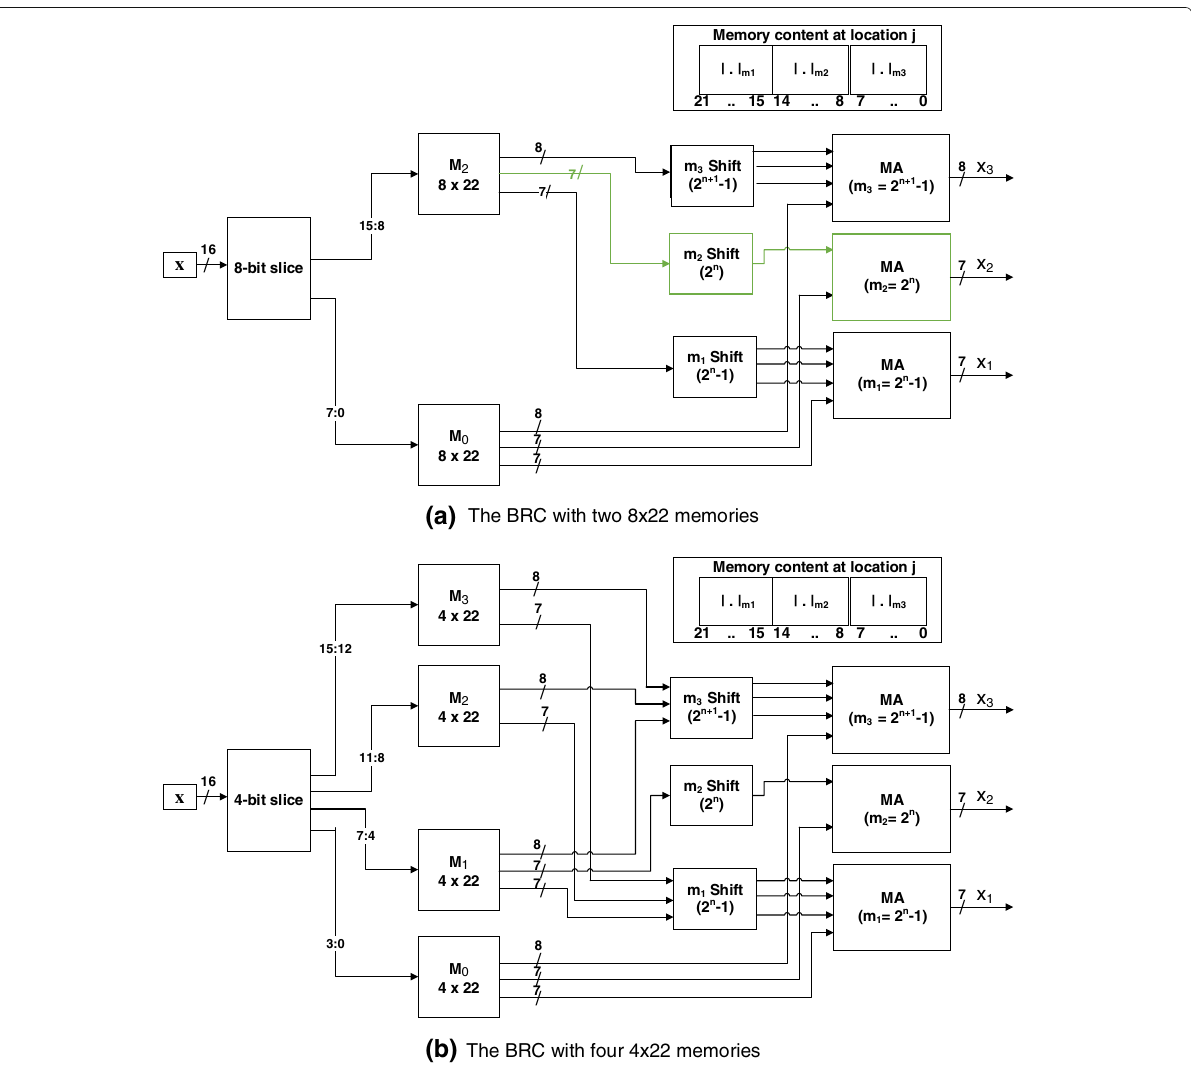
Fig. 5 The block diagram of the binary-to-residue converter for the three-channel RNS-based DWT, P 7 = { 127,128,255 } ( a ) with two, ( b ) with four identical memories. The green blocks are not required because the shift result is always zero for m 2 . The memory content at location j is as shown in the upper